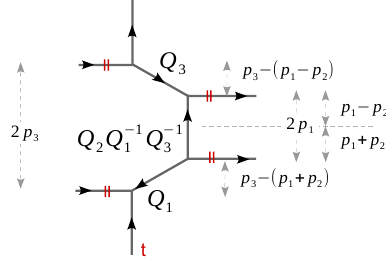
Figure 11 . Parametrisation of distances between pairs of external parallel legs of a